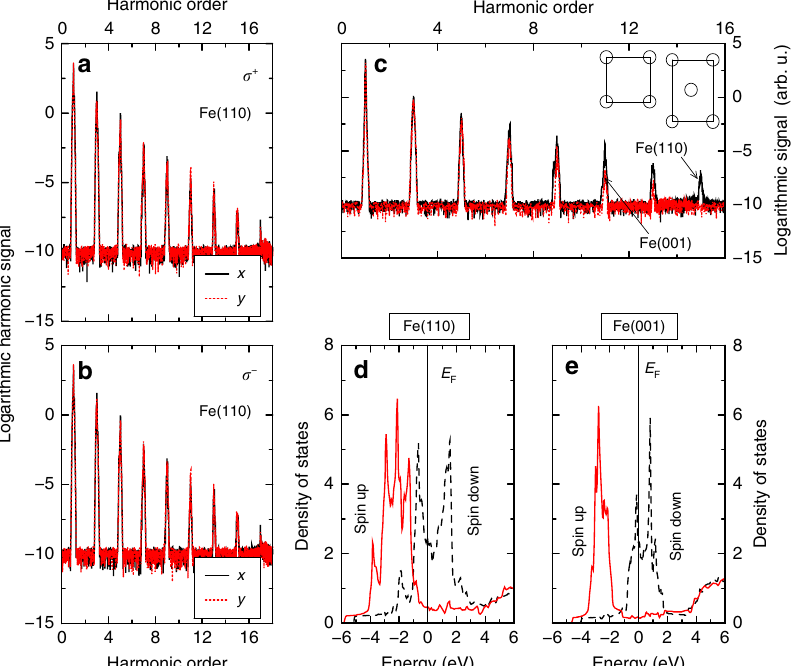
Fig. 3 Effects of laser-helicity and fi lm orientation on harmonic signals. a , b Logarithmic harmonic signal from the Fe(110) monolayer with right ( σ + ) and left ( σ − ) circularly polarized light, respectively, where the laser polarization is in the xy plane (see Fig. 1). Due to the window function, the difference between the x and y components is not obvious, but the real time P y ( t ) is larger than P x ( t ) for most of the time (see Supplementary Fig. 3). c Comparison between HHG signals in the Fe(110) and Fe(001) monolayers, where the laser polarization is along the z axis. d Density of states for the Fe(110) monolayer. The solid and dashed lines denote the spin-up and spin-down density of states, respectively. The Fermi level is at E F = 0 eV (see the thin vertical line). e Density of states for the Fe(001)